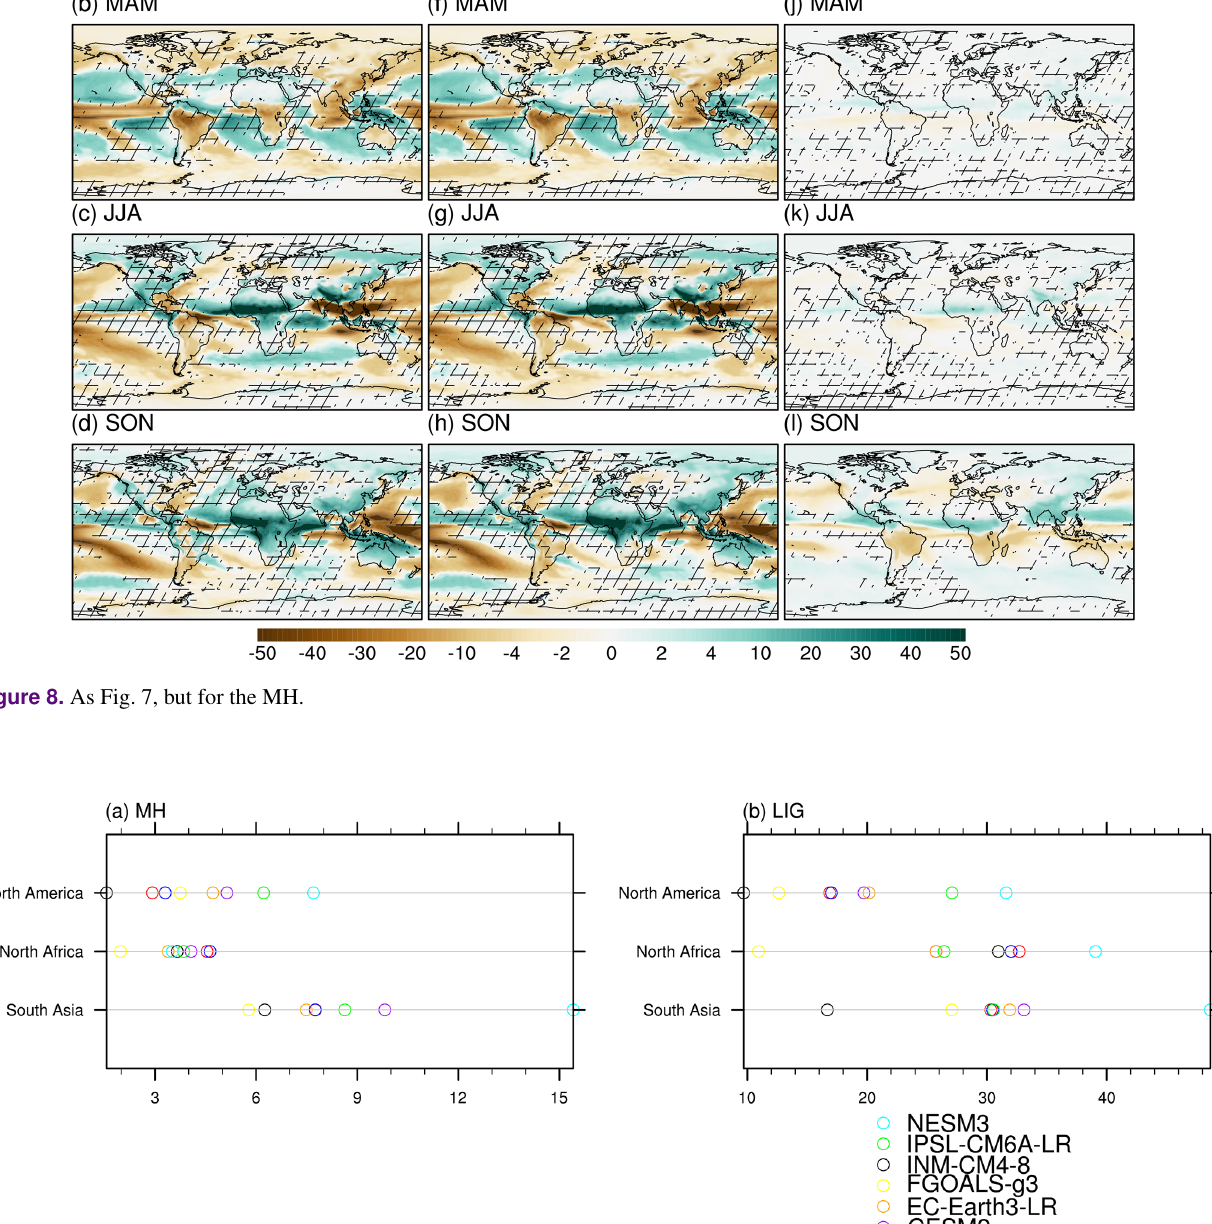
Clim. Past, 18, 1047–1070, 2022